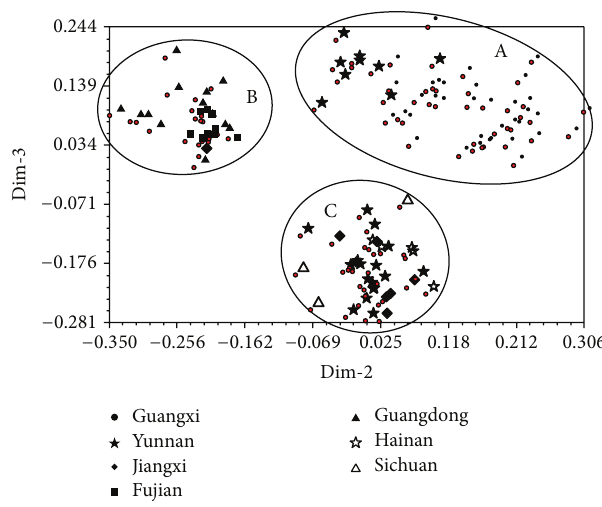
Figure 7: Principal components analysis (PCA) of S. scitamineum (numbers 1–100) based on the combined ISSR + SP-SRAP data set.